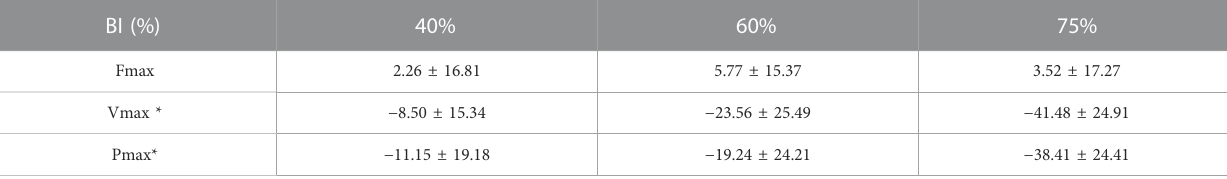
The mean and SD, were calculated over 18 values (1 for each participant), each of which was the trial in which maximum power was developed. The (*) indicates the variables for which BI, presentedsigni fi cantdifferencesbetweenloadconditions.NegativesignsinthemeanBI,valuesindicateBLD,whilepositivesignsindicateBLF.The posthoc showsdifferencesforspeedbetween 40% and 60% ( p < 0.05); and 40% and 75% ( p < 0.001); and 60% and 75% ( p < 0.05) and for power between 40% and 75% ( p < 0.01); and 60% and 75% ( p <